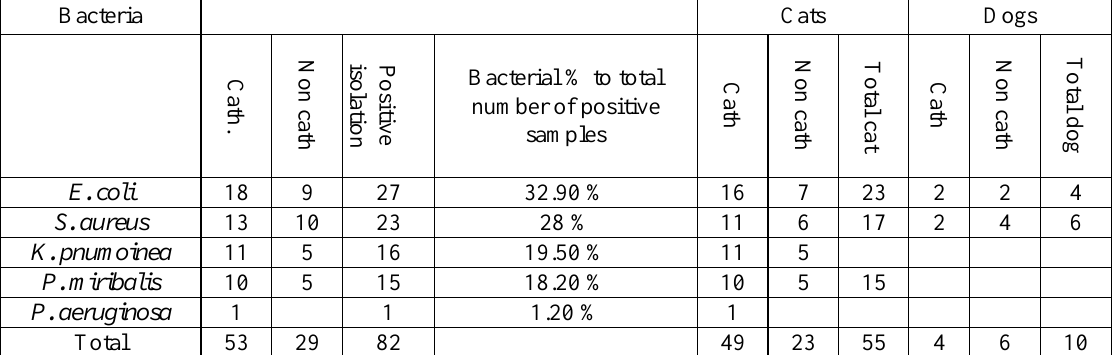
Table 3: Prevalence of bacterial UTIs catheterized and noncatheterized cats and dogs Bacteria